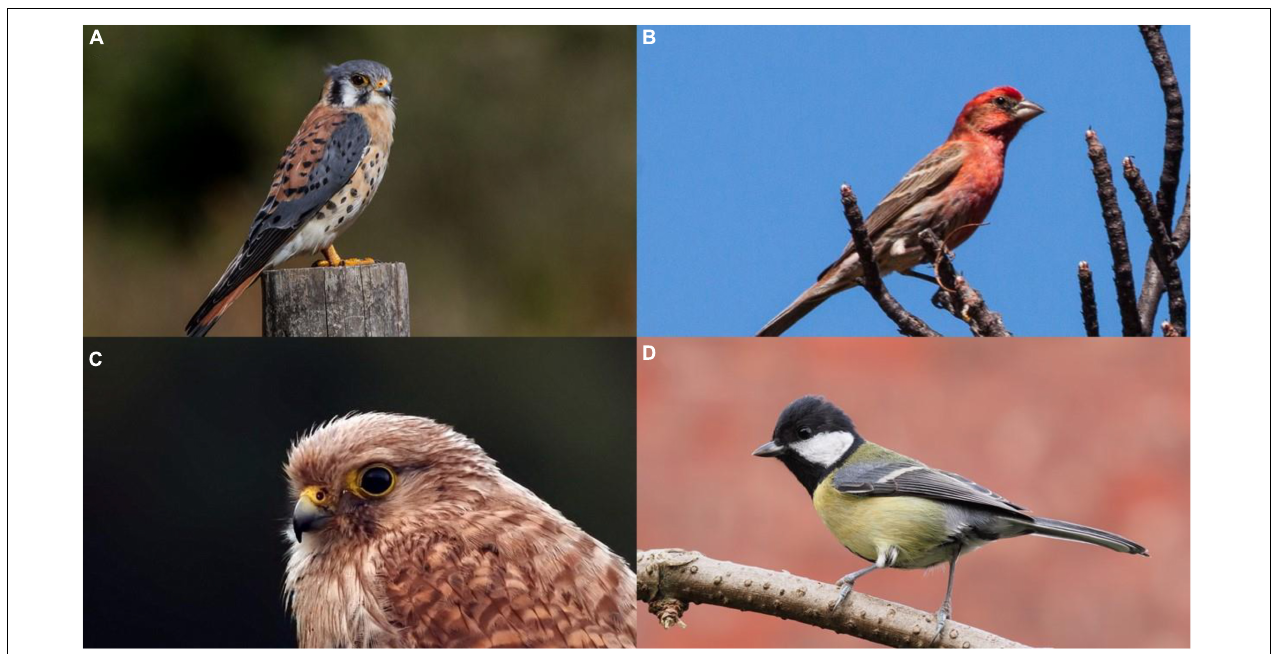
FIGURE 1 | Birds whose pigmentation is affected by environmental pollution. (A) The American kestrel (Falco sparverius) in Florida, by Andrew Morrfew. Male kestrels that were fed PCBs in the laboratory setting showed duller plumage coloration (B) House finch (Haemorhous mexicanus) in Baja California, by Ron Knight. The house finch exhibits a decrease in red plumage coloration with exposure to herbicides. (C) Eurasian kestrel (Falco tinnunculus) in the Annamalai Hills, by T.R. Shankar Raman. The melanin-based plumage color has been shown to fluctuate in response to diet diversity (Fargallo et al., 2007). (D) Great tit (Parus major) in Lancashire by Francis Franklin. The yellow breast coloration has been shown to grow duller with exposure to metal pollutants, while melanin-based black stripes grow